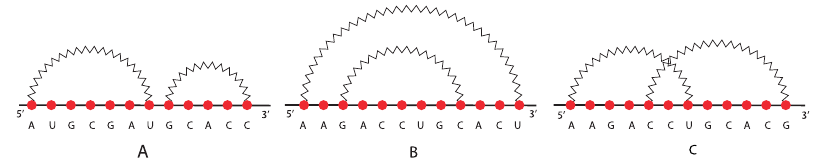
Figure 2: Relations between two loops: (A) concatenation, (B) nesting and (C) crossing of two